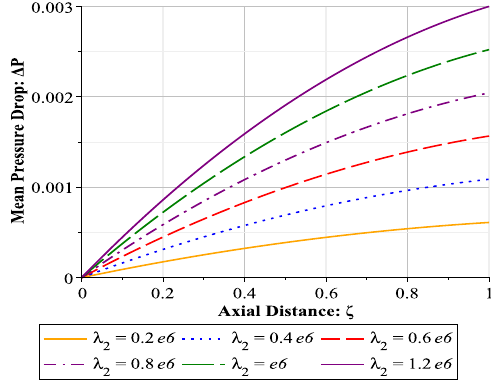
Figure 7. Behavior of ∆ P with ζ for different values of λ 2